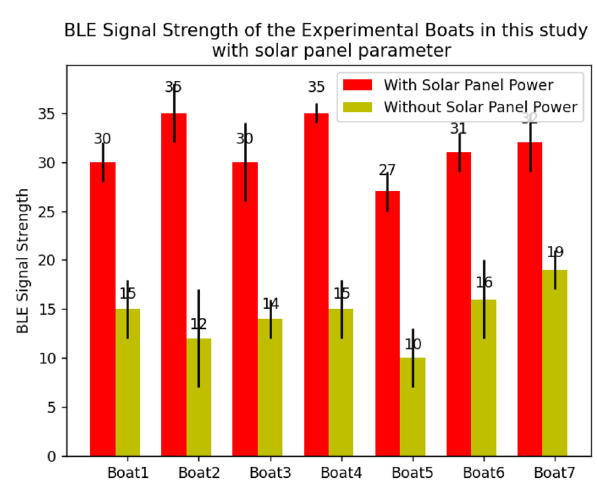
Fig. 9 Experimental result of BLE signal strength with solar panel parameter a red line indicated BLE signal strength with solar panel power; b brown line indicated BLE signal strength without solar